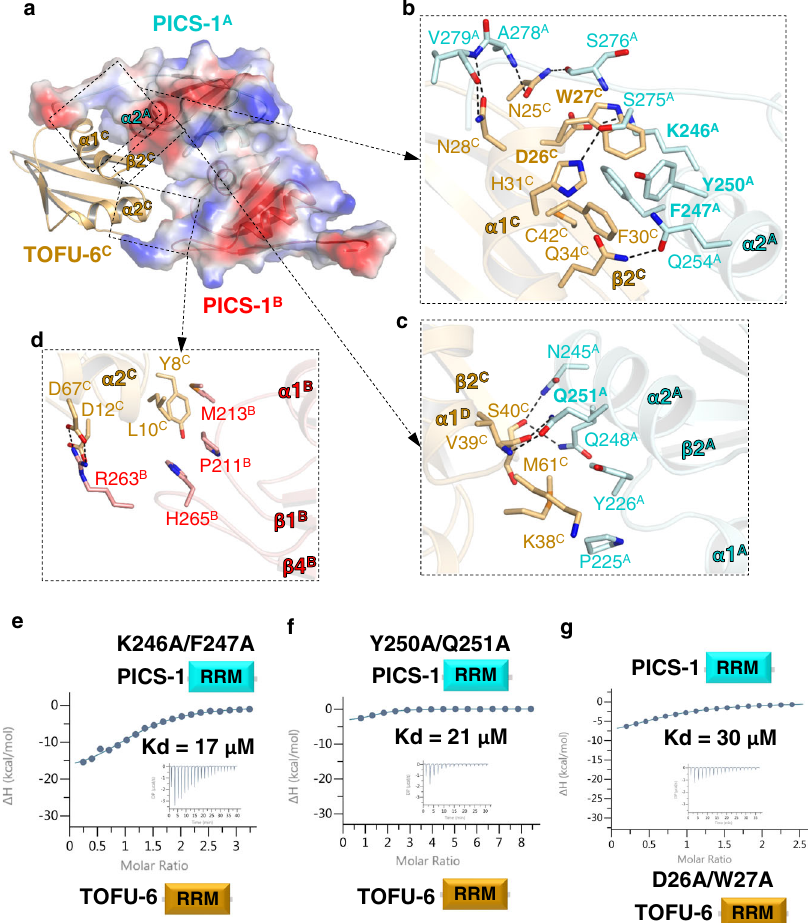
Fig. 2 The PICS-1 RRM dimer bind to Two TOFU-6 RRM molecules. a The electrostatic surface of the PICS-1 RRM dimer bound with TOFU-6 RRM . Due to symmetry, only one TOFU-6 RRM molecule, TOFU-6 C is shown in orange cartoon. b , c Detailed interactions between TOFU-6 C and one PICS-1(PID-3) protomer, PICS-1 A . d Detailed interactions between TOFU-6 C and the other PICS-1(PID-3) protomer, PICS-1 B . In Fig. 2b – d, residues involved in TOFU-6/ PICS-1 interaction are shown in sticks. Hydrogen bonds are shown in black dashes. e , f ITC binding curves for mutants of PICS-1 RRM with TOFU-6 RRM . g ITC binding curves for PICS-1 RRM with TOFU-6 RRM